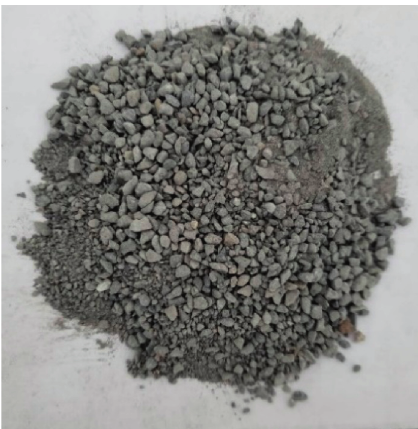
Figure 1: Manufactured sand. Table 6: Manufactured sand screening test results.